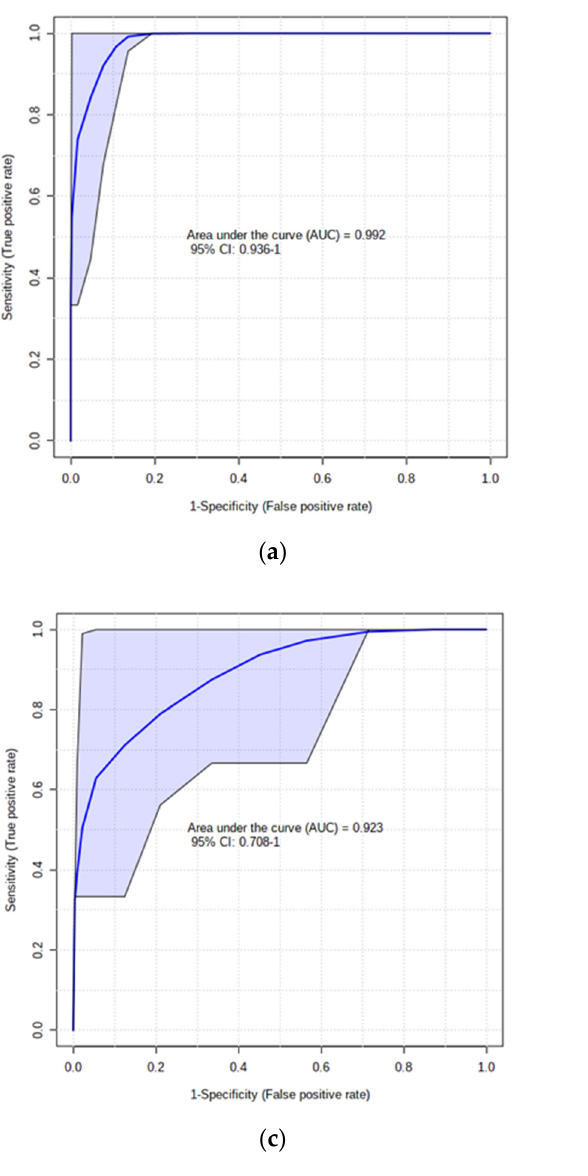
Figure 4. ( a ) AUC of the top 5 VIP PLS-DA metabolites at − 4 weeks before parturition and ( b ) AUC of model’s classifica- tion; ( c ) default linear SVM AUC model (AUC = 0.92; p = 0.01); ( d ) ROC plot with 10-fold CV for logistic regression algo- rithm (AUC = 0.81, p =